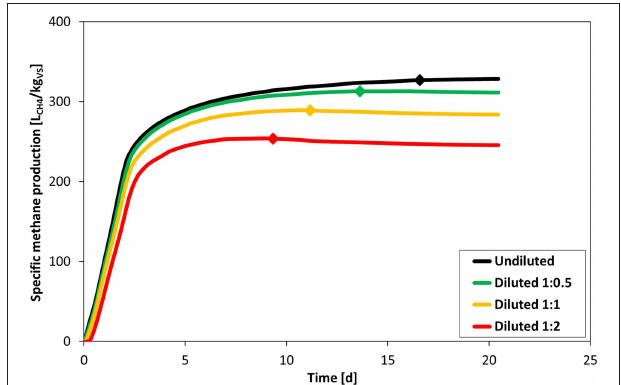
FIGURE 3 | Impact of inoculum dilution on specific methane production. Plotted values are the mean of three replicate bottles for each condition. Diamonds indicate the time when the daily gas production was below 1% of cumulative production during 3 consecutive